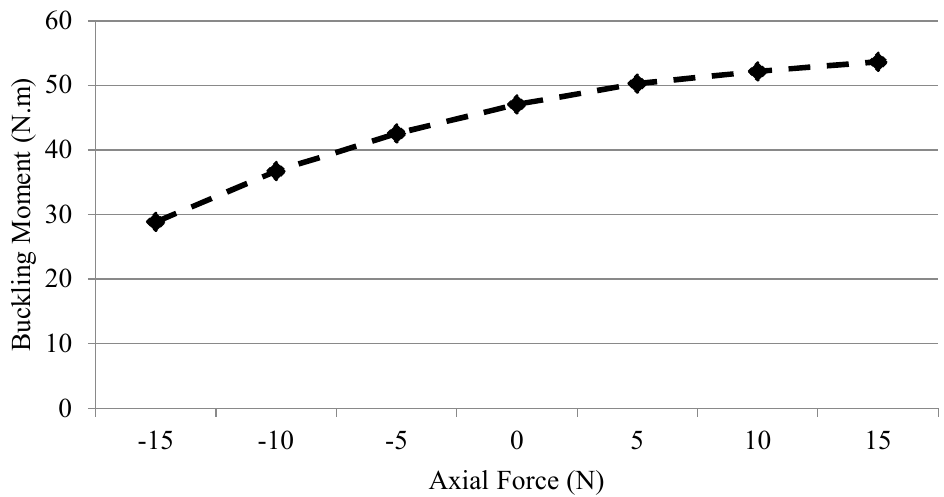
Figure 11. Buckling analysis for the cantilevered, three-layer glass–epoxy and aluminum sandwich beam (GLARE), using five-element DFE (negative axial force means compression, while positive means tension).